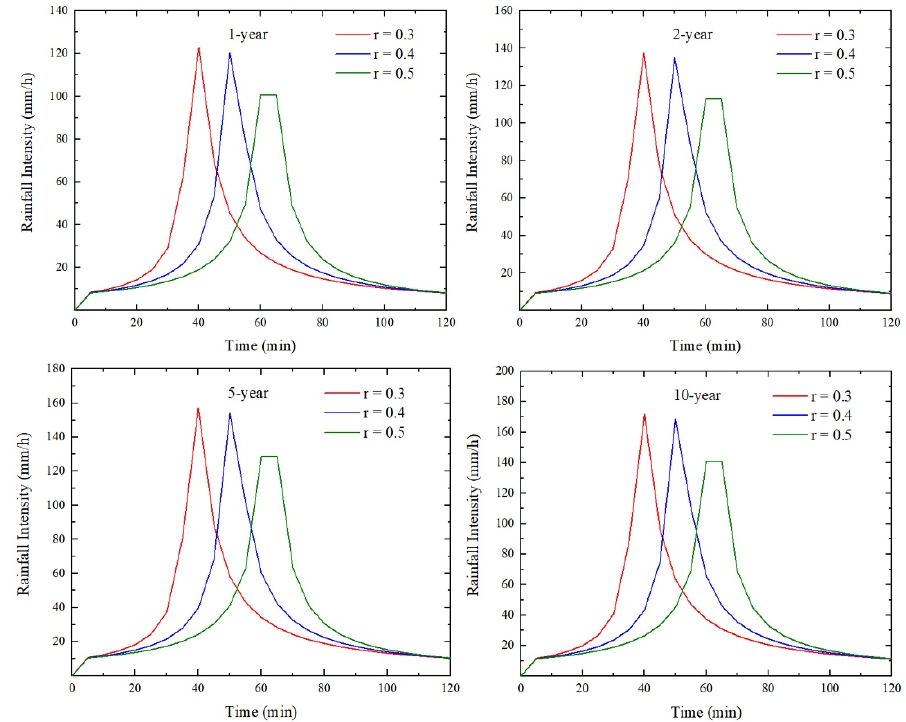
Figure 2. Hydrographs of the designed rainfall events ( t = 120 min).